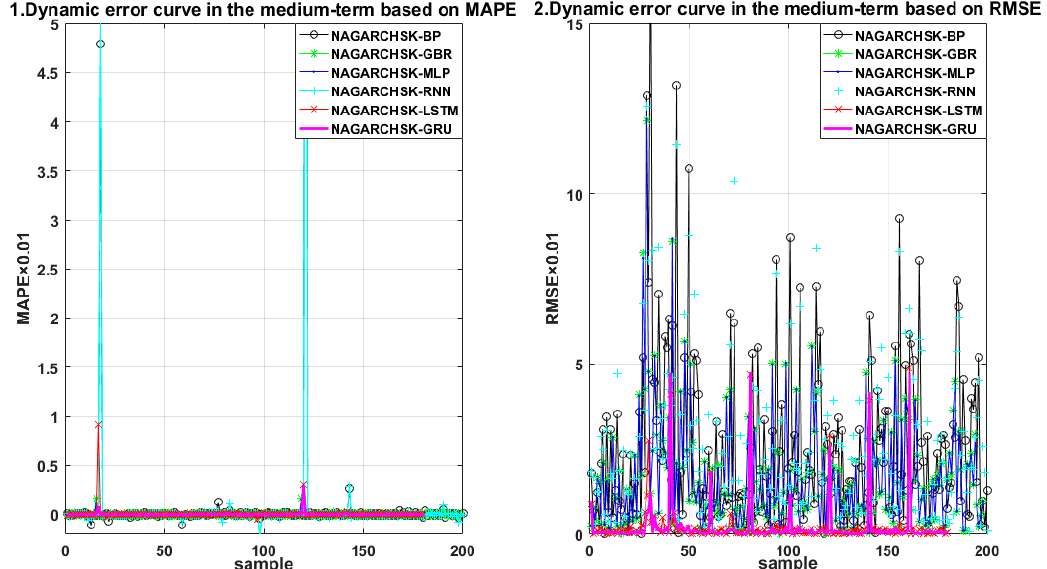
Figure 8. Error scatter distribution of the proposed and benchmark forecasting models considering the feature of time-varying, high-order moment in the medium term.